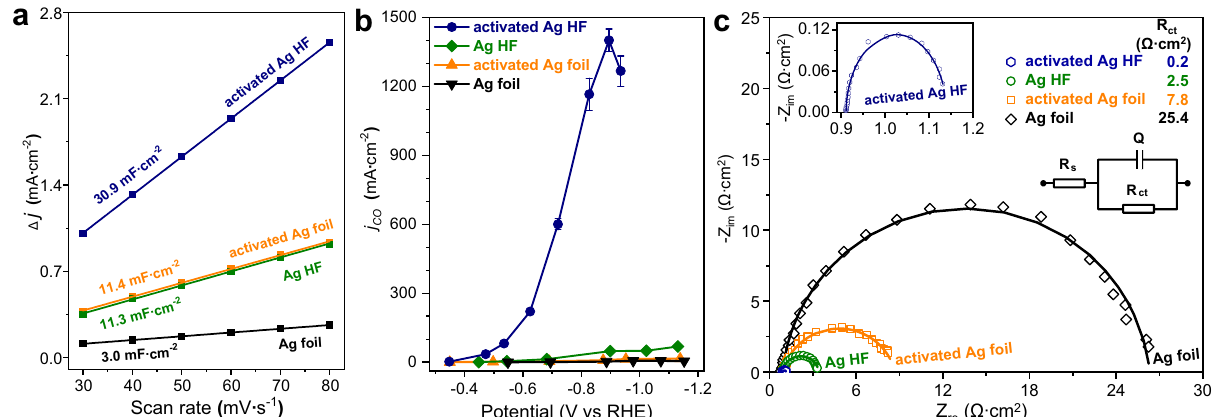
Fig. 4 Electrochemical characterization. a Plot of Δ j (the difference of cathodic and anodic current densities, j c – j a ) against the scan rates from cyclic voltammetry curves (Supplementary Fig. 16), b CO partial current density comparison, and error bars were obtained from the average of six individual tests. c EIS Nyquist plots of activated Ag HF, Ag HF, activated Ag foil and Ag foil. The inset in c shows the equivalent